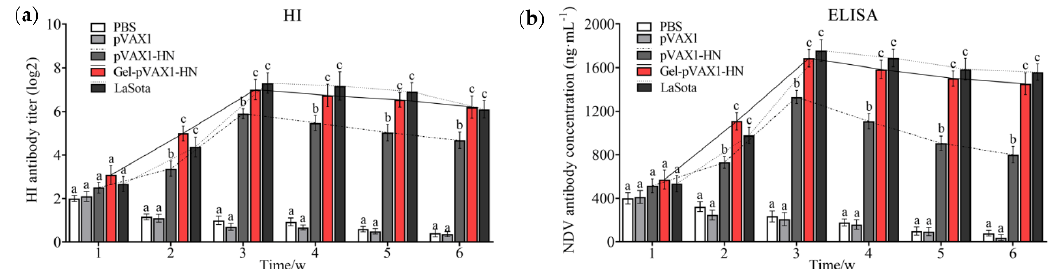
Figure 4. Humoral immune response assay of the NDV DNA hydrogel vaccine. The chickens were inoculated with PBS, pVAX1 plasmids, pVAX1-HN plasmids, and pVAX1-HN plasmids encapsulated in the hydrogel (Gel-pVAX1-HN) and commercial attenuated vaccine (LaSota), then the serum samples were collected at each predetermined time for the hemagglutination inhibition test ( a ) and ELISA assay ( b ). The results are expressed as the mean ± SD of three independent experiments. Bars at the same week with different superscripts mean significant differences ( p < 0.05).